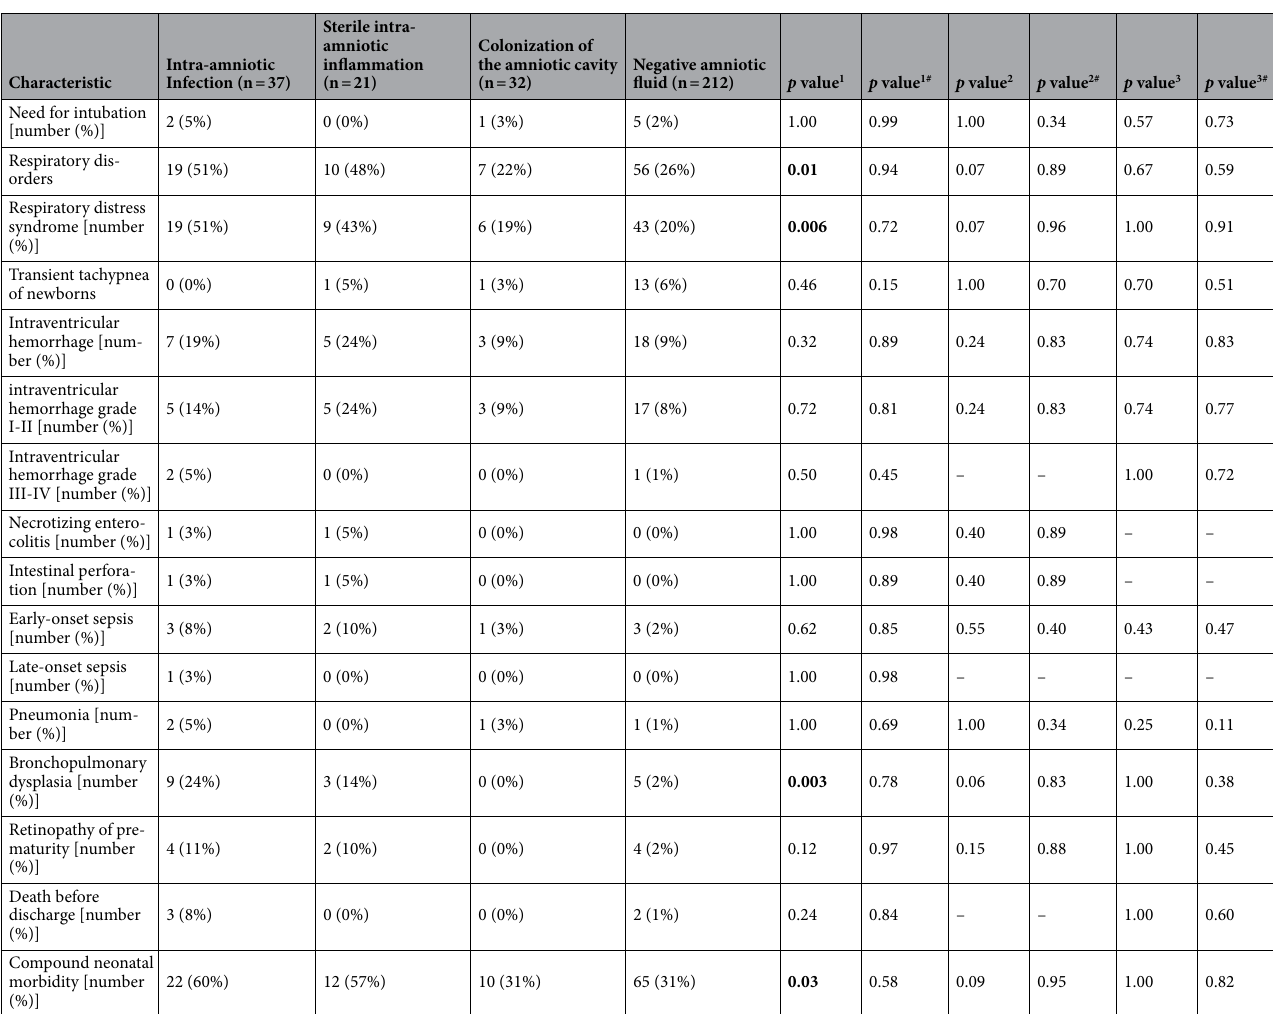
Table 4. Short-term neonatal morbidity of newborns from pregnancies with PPROM with respect to intra- amniotic infection, sterile intra-amniotic inflammation, colonization, and negative amniotic fluid. Variables were compared using the Fisher’s exact test and are presented as number (%). Statistically significant results are marked in bold. p- value 1 —comparison between women with colonization of the amniotic cavity and with intra-amniotic infection. p- value 2 —comparison between women with colonization of the amniotic cavity and with sterile intra-amniotic inflammation. p- value 3 —comparison between women with colonization of the amniotic cavity and with negative amniotic fluid. # the results were adjusted for gestational age at